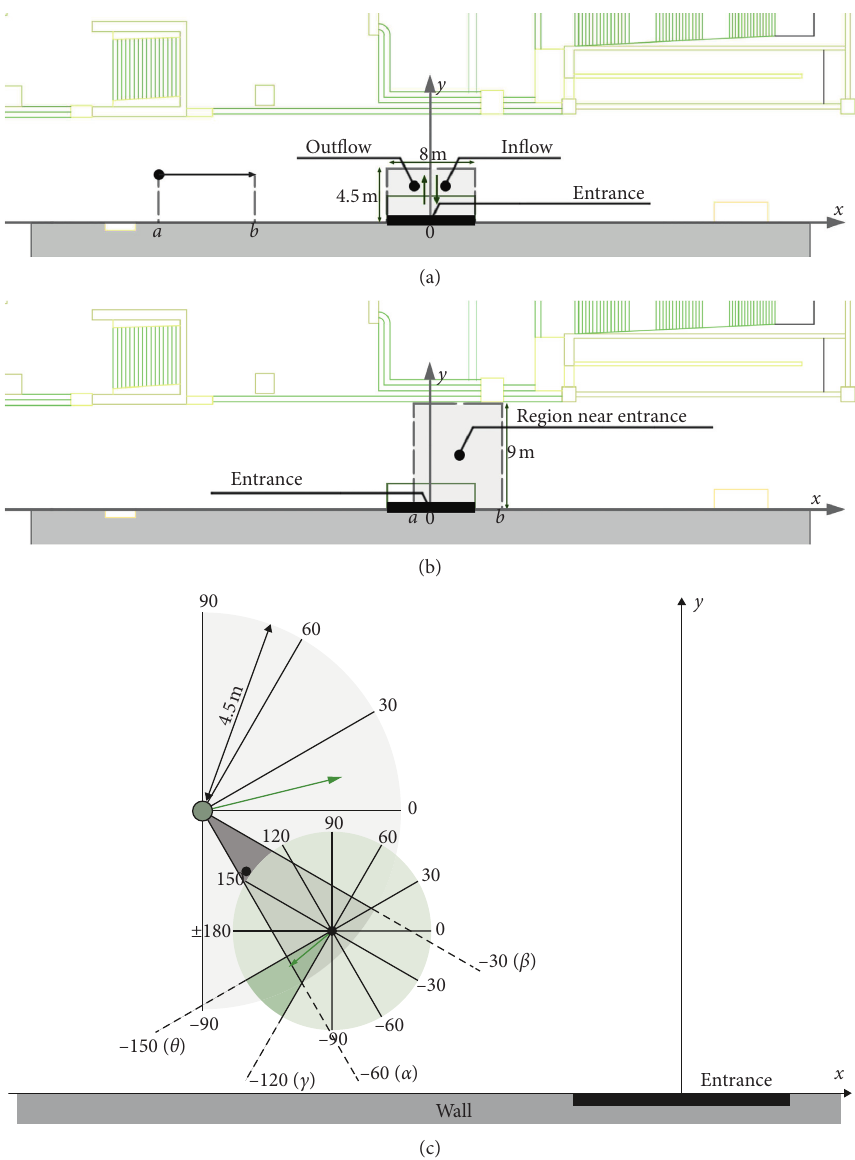
Figure 2: The variables used to quantify the movement dynamics in front of the entrance of a building and near a subject; the entrance is indicated by a black bar and the subject is indicated by a green circle. (a) Entrance flow. (b) Entrance density. (c) Interacting